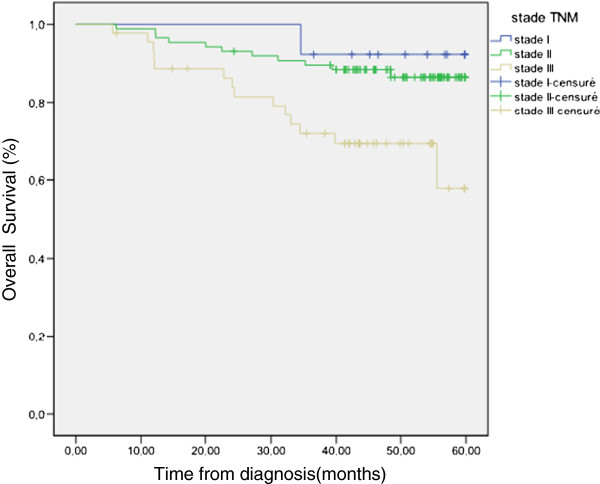
Survival for localized patients accordigng to TNM staging.